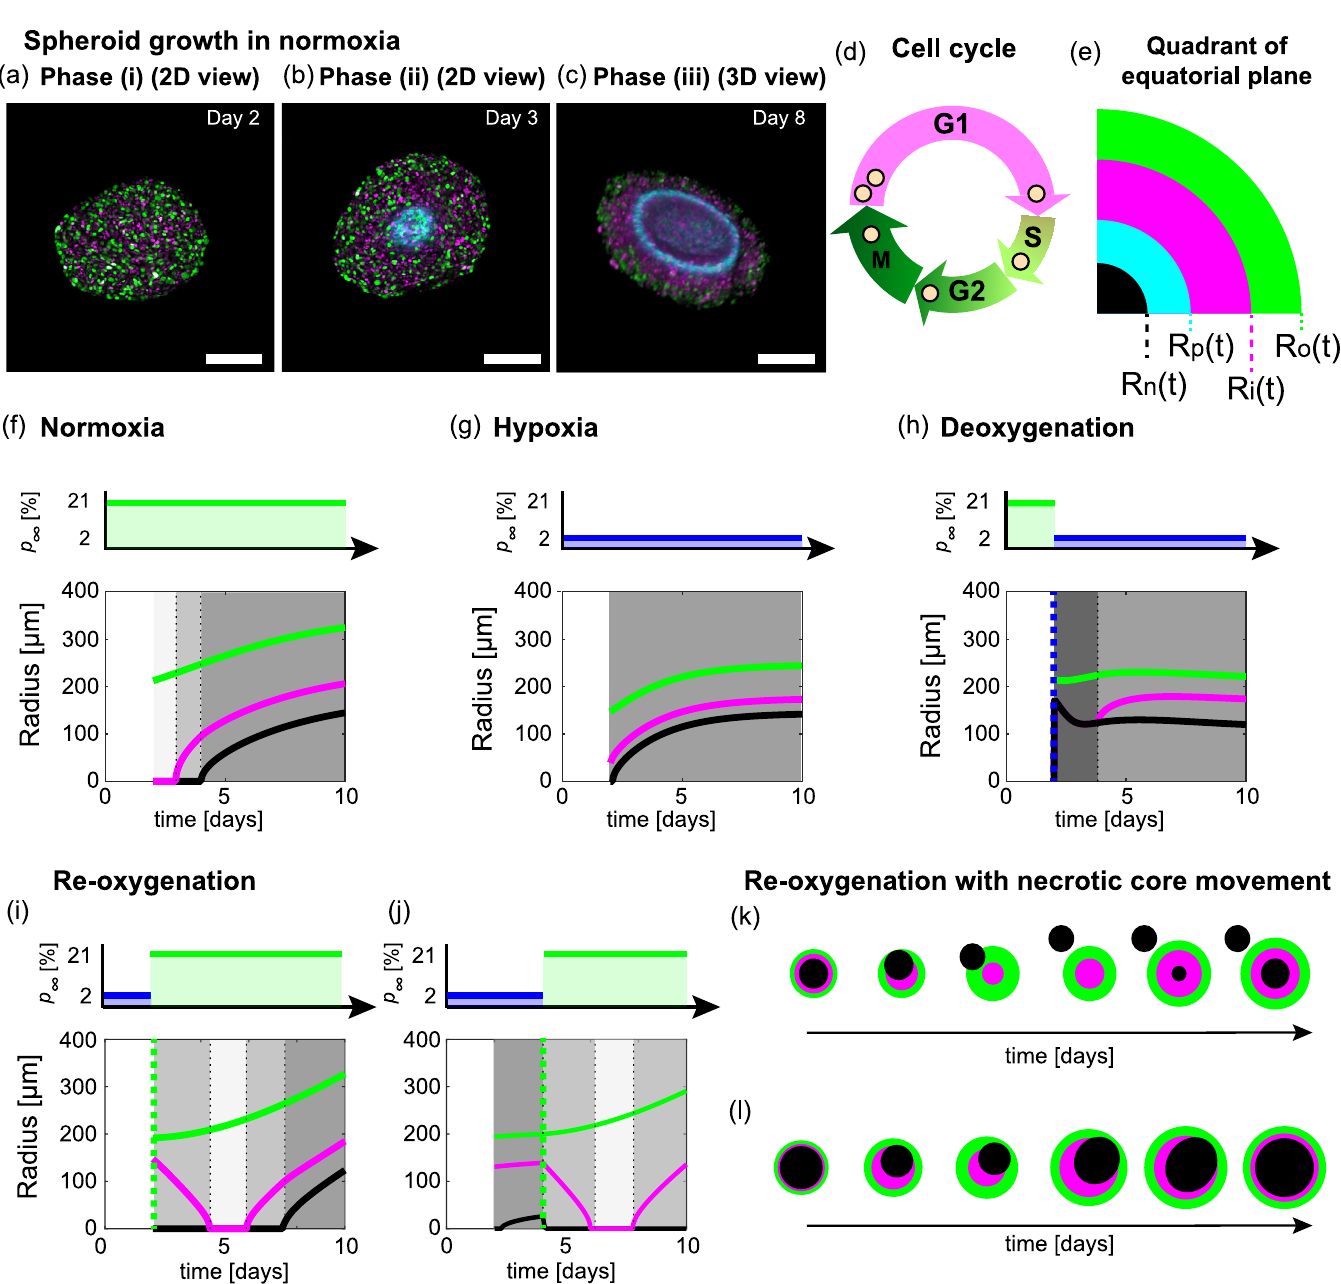
Fig 1. Impact of external environment on the structure of growing tumour spheroids: A focus on oxygen availability. (a-c) Tumour spheroid growth in standard experimental protocols occurs in three phases. Experimental images shown for FUCCI-transduced human melanoma WM983b spheroids grown in normoxia. (a-b) Experimental images of the equatorial plane of spheroids on Day 2 and 3 after seeding. (c) 3D z-stack representation of half of a spheroid on Day 8 after seeding. Scale bars are 200 μ m. Colours in (a-c) correspond to cell cycle schematic shown in (d): cells in G1 phase (magenta) and cells in S/G2/M phase (green). Pimonidazole staining reveals the hypoxic regions of spheroid (cyan). (e) Schematic for spherically symmetric spheroid structure representing a quadrant of the equatorial plane of a spheroid. Spheroids in normoxia experience three phases of growth, resulting in a spheroid with three regions at later times: a central region composed of a necrotic core, 0 < r < R n ( t ) (black); an intermediate region of living but proliferation-inhibited cells, R n ( t ) < r < R i ( t ) (magenta); and, a region at the periphery composed of living and proliferating cells, R i ( t ) < r < R o ( t ) (green). The hypoxic radius, R p ( t ) (cyan) satisfies R n ( t ) � R p ( t ) � R o ( t ). (f-j) Schematics for oxygen conditions and time evolution of spheroid structure and overall size in (f) normoxia, (g) hypoxia, (h) deoxygenation experiments, and (i-j) re-oxygenation experiments where spherical symmetry is maintained. Note in (i-j) spheroids transiently undergo the growth phases in reverse. Greyscale shading in (f-j) represent growth phases. (k-l) Schematics for re- oxygenation experiments where we do not observe spherically symmetry due to (k) necrotic core removal and (l) movement of the necrotic core without removal. For additional experimental images for each condition with the boundaries of the proliferating, inhibited and hypoxic regions overlayed see Text A.2 in S1 File.